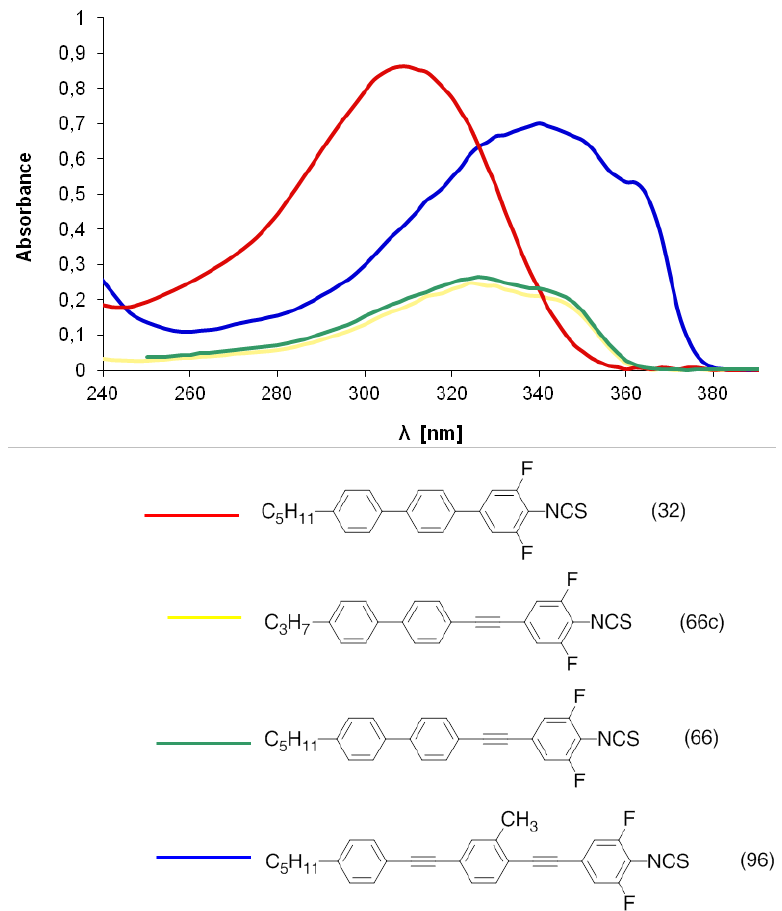
Figure 11. Electronic spectra of compounds 32 , 66 , 66c and 96 (6.0–6.5 μg/mL in